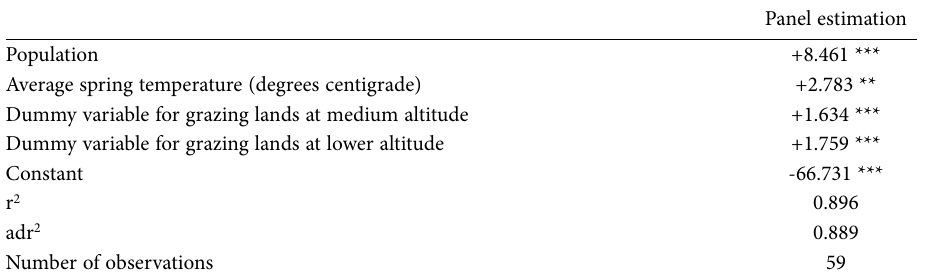
Table 1. Estimated results for all the mountain